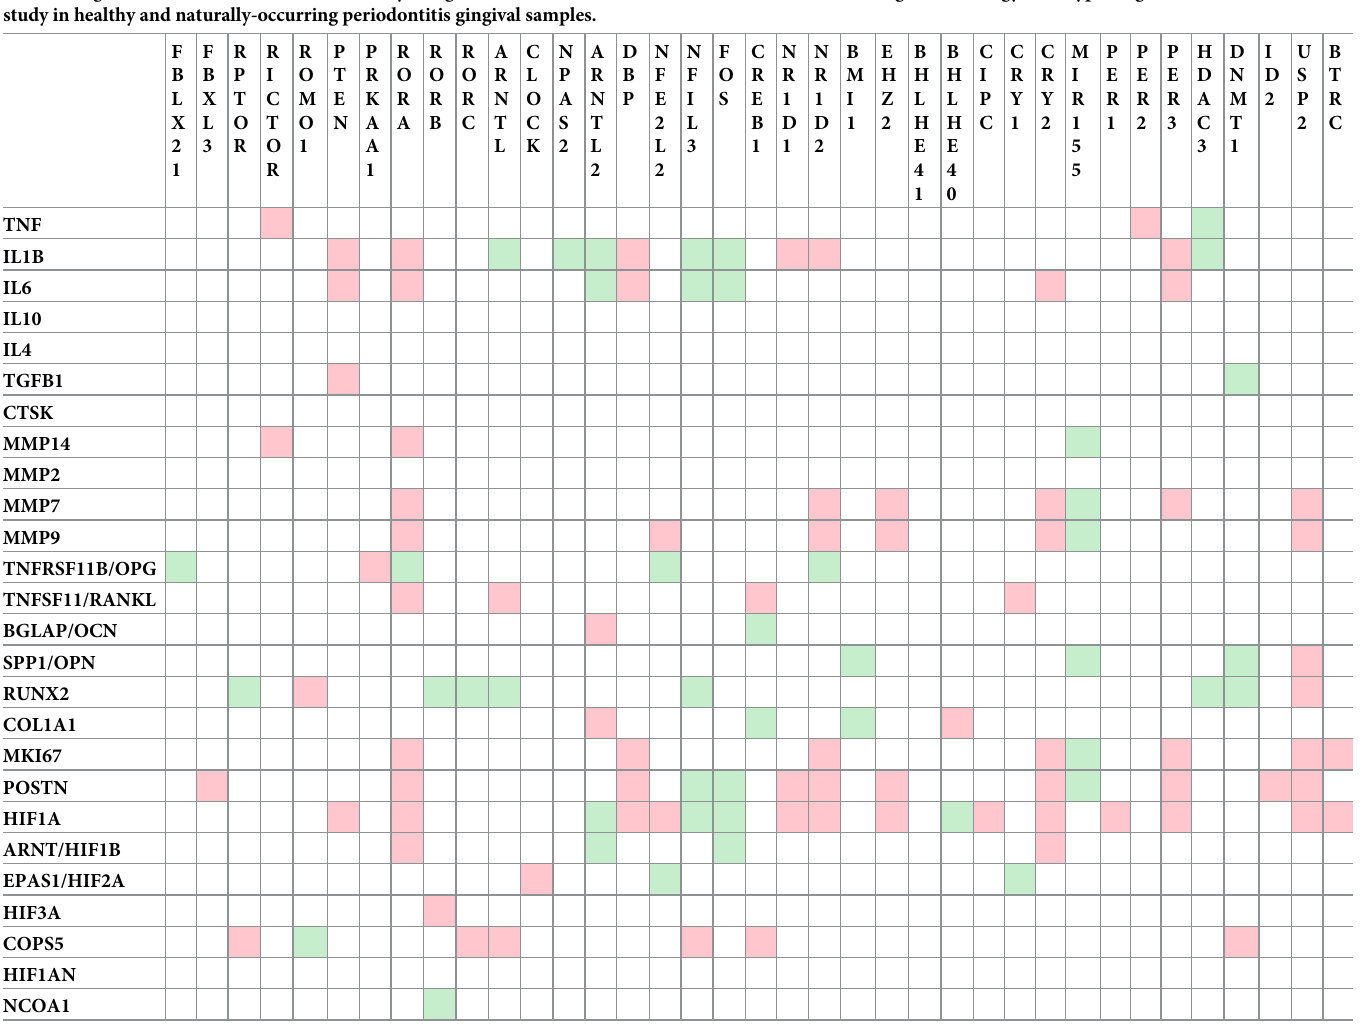
With respect to the bone biology genes, there was a limited array of interactions in healthy tissues ( Table 4 ). With disease, RANKL, MKI67, and POSTN demonstrated numerous correlations with the circadian genes, with RICTOR, DBP, CREB1, and EZH2 showing association with multiple bone biology genes. In resolution samples, numerous correlations with the circadian genes were shown with SPP1/OPN, COL1A1, MKI67, and POSTN bone biology genes. Only DBP and EZH2 circadian genes exhibited frequent correlations with the bone biology genes with disease resolution. Additionally there was substantial overlap in the repertoire of circadian genes demonstrating multi- ple correlations with the bone biology genes, including RORA and PER1 in health, RPTOR, RORA, DBP, NR1D2, PER1, and USP2 in disease, and RORA and DBP in resolution samples. In health and disease, except for HIF1A, virtually all of the correlations between circadian and hypoxia genes were positive ( Table 4 ). With disease, the circadian genes RPTOR, RORA, DBP, EZH2, MIR155, PER2, PER3 and USP2 were all enriched for these correlations. Interes- tingy, both FOS and PER demonstrated somewhat unique patterns of negative correlations